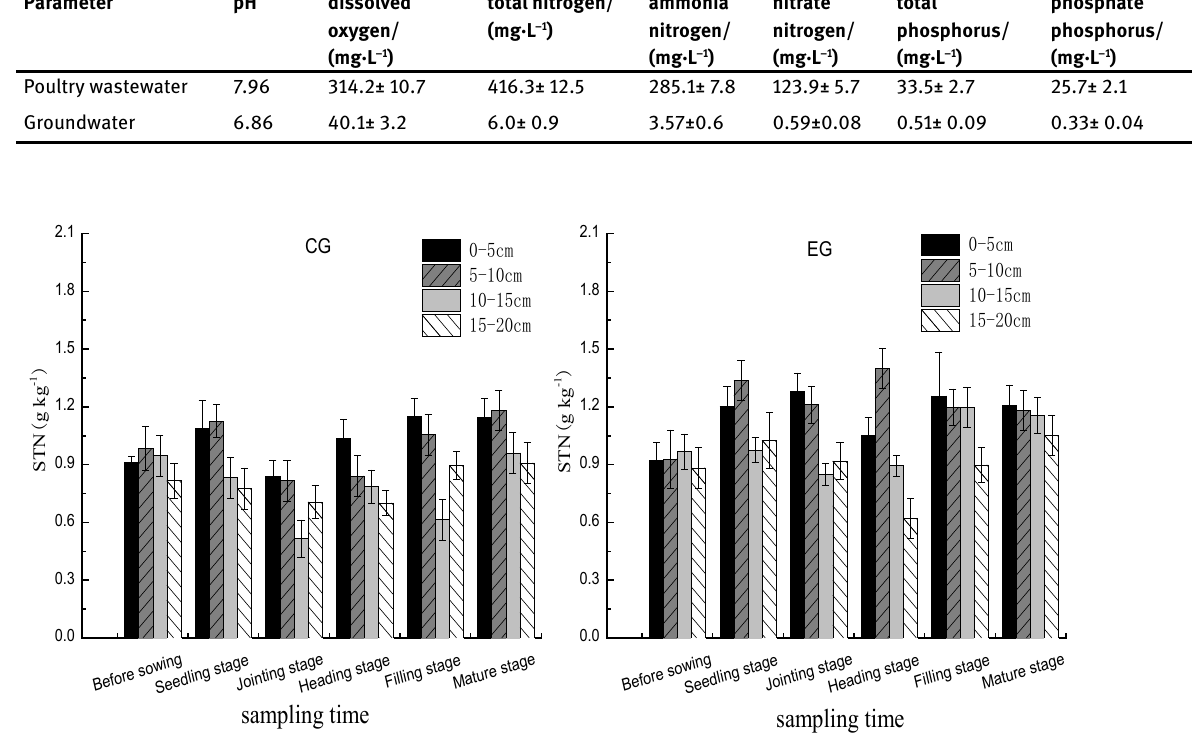
Table 1: Mean values of the main irrigation water parameters in each group farmland. Parameter